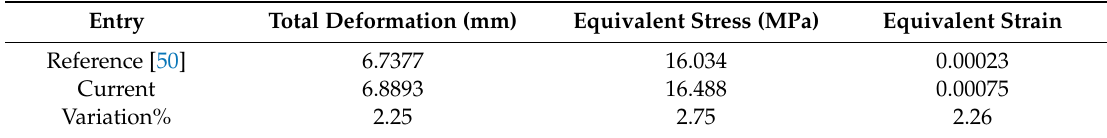
Table 3. Comparison between the results of static analysis of aircraft wing obtained from the current study and literature [50].